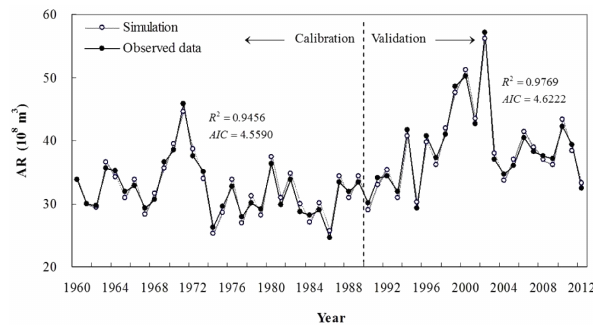
Figure 12. Comparisons between the observed data of AR and its simulated values for calibration period (1960–1989) and validation period